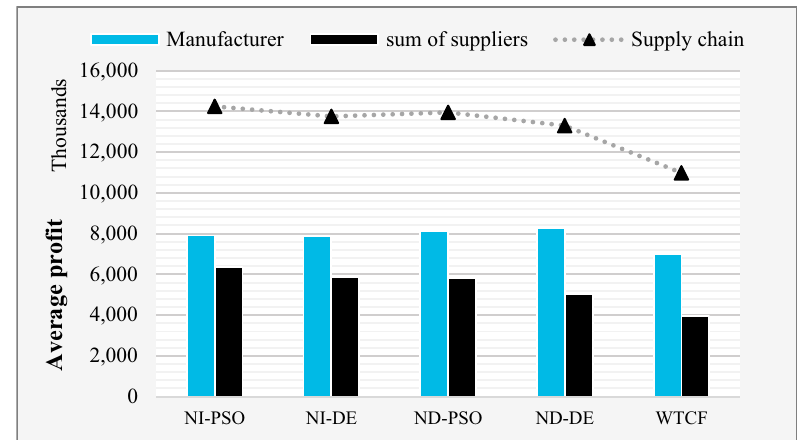
Fig. 7 A comparison between the performance of the proposed solution algorithms in problem size